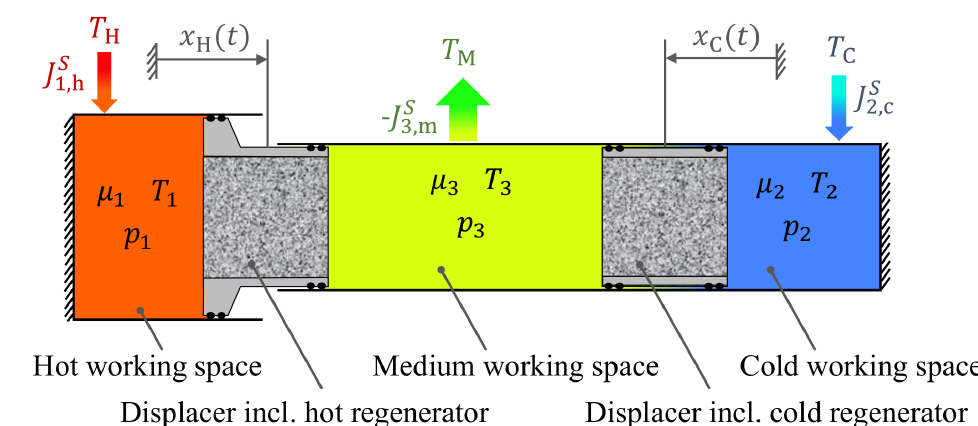
Figure 1. Schematic representation of a Vuilleumier engine consisting of the three subsystems 1, 2, and 3, which are connected by two displacer pistons with postions x H ( t ) and x C ( t ) . The subsystems represent the working spaces containing the working fluid characterized by its temperature T i , its pressure p i , and its chemical potential µ i . The working spaces exchange entropy fluxes J S 1,h , J S 3,m , and > T > T J S T 2,c with external heat baths with temperatures H M C , respectively. The pistons control the volume of the adjacent subsystems and additionally act as regenerators. Note the surface differences between both ends of the hot-side piston, which is required in order to gain the power to operate the piston